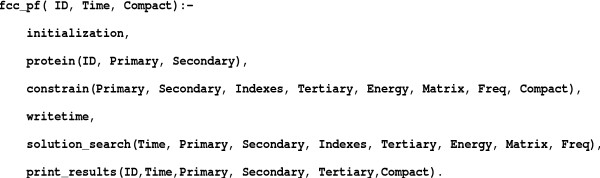
Main program predicate.